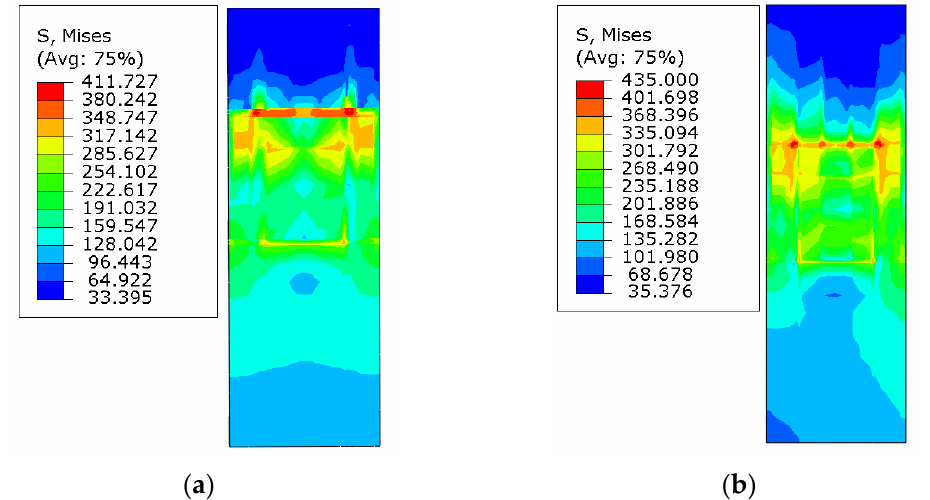
Figure 14. Von Mises stress contours of the left flange of steel tube in the connection zone: ( a ) RS connection; ( b ) RT connection.